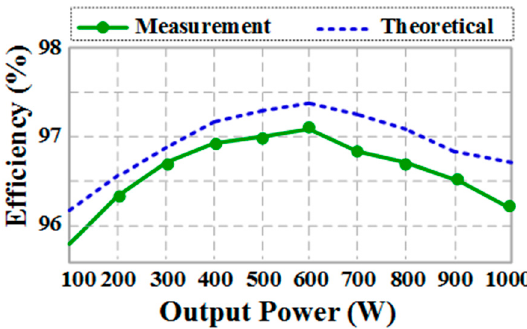
Figure 14. Calculated and measured efficiency versus output power.